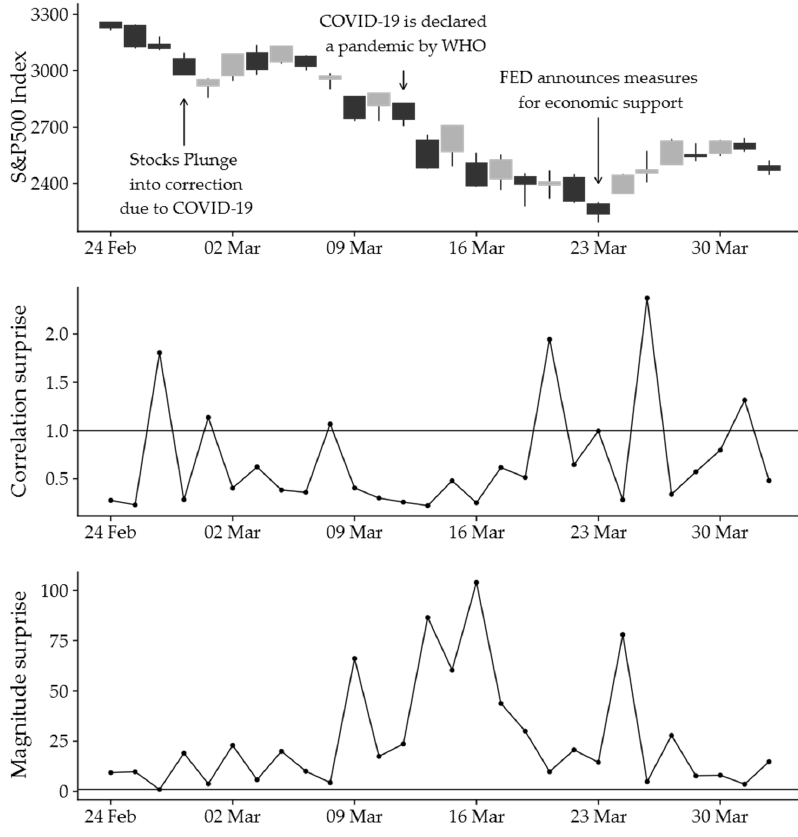
Figure 6. Analysis of the financial turbulence, February–March 2020.